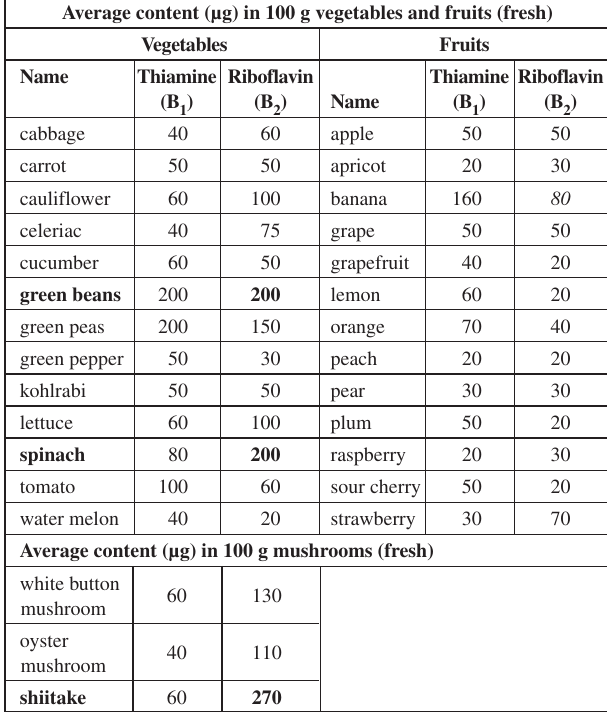
Table 5 Average thiamine and riboflavin content (µg) in 100 g vegetables, fruits and mushrooms